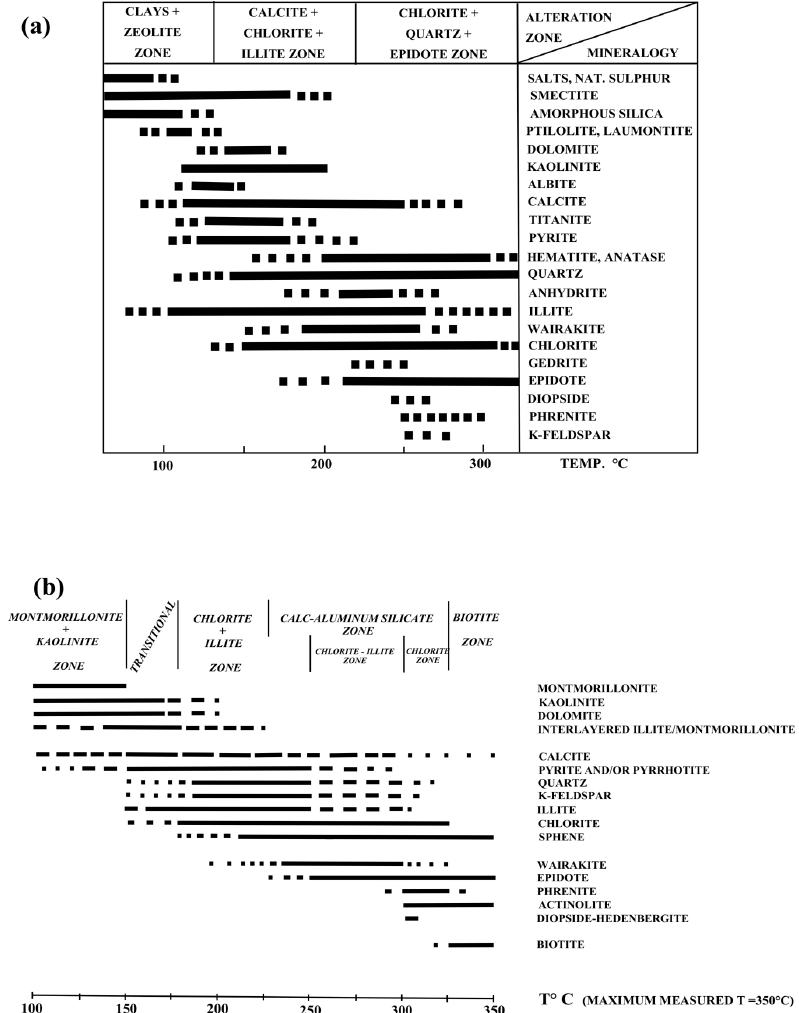
Figure 2. Mineral zoneography as a function of temperature reported for: ( a ) Los Azufres (redrawn from Cathelineau et al. [35]) and ( b ) Cerro Prieto (redrawn from Elders et al. [36]) geothermal fields.